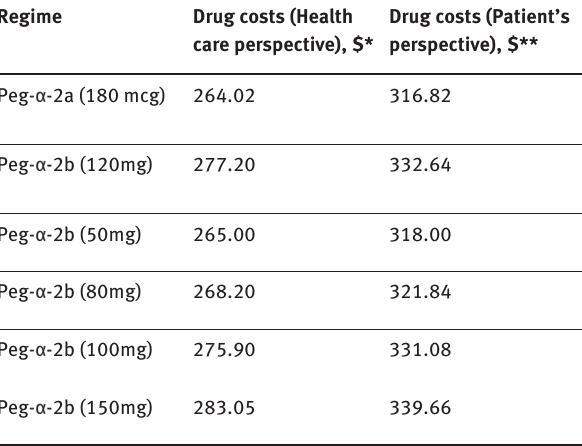
Table 1: Cost of drug treatment: HCV genotype 1.